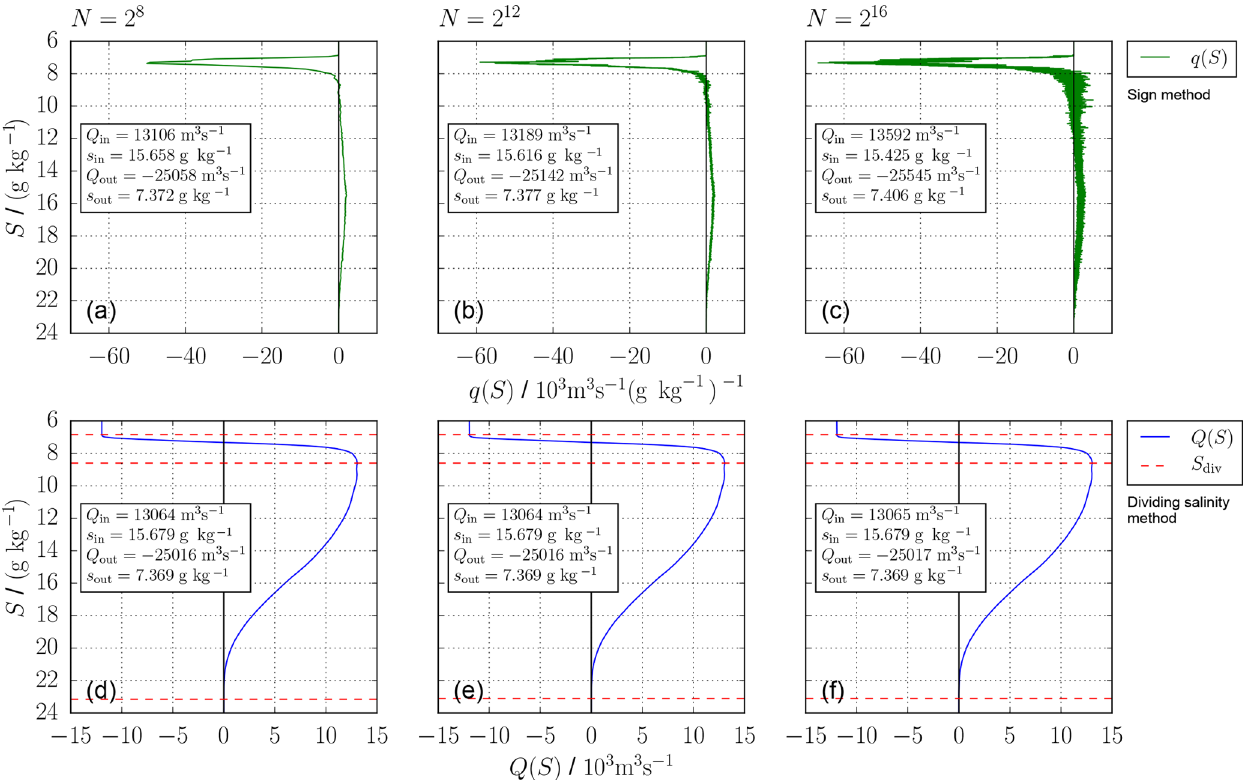
Figure 7. Exchange flow over Darss Sill: profiles of q (a, b, c) and Q (d, e, f) for the Darss Sill transect in 2002/2003 depending on the number of salinity classes N : (a, d) N = 2 8 = 256, (b, e) N = 2 12 = 4096, (c, f) N = 2 16 = 65536. The respective TEF bulk values are calculated with the sign method (5) in panels (a, b, c) and the extended dividing salinity method (11, 16) in panels (d, e, f)